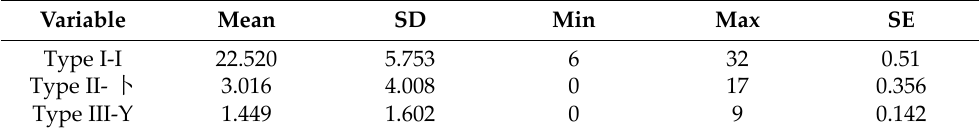
Table 1. Distribution of intermuscular bones by X‑ray imaging method.